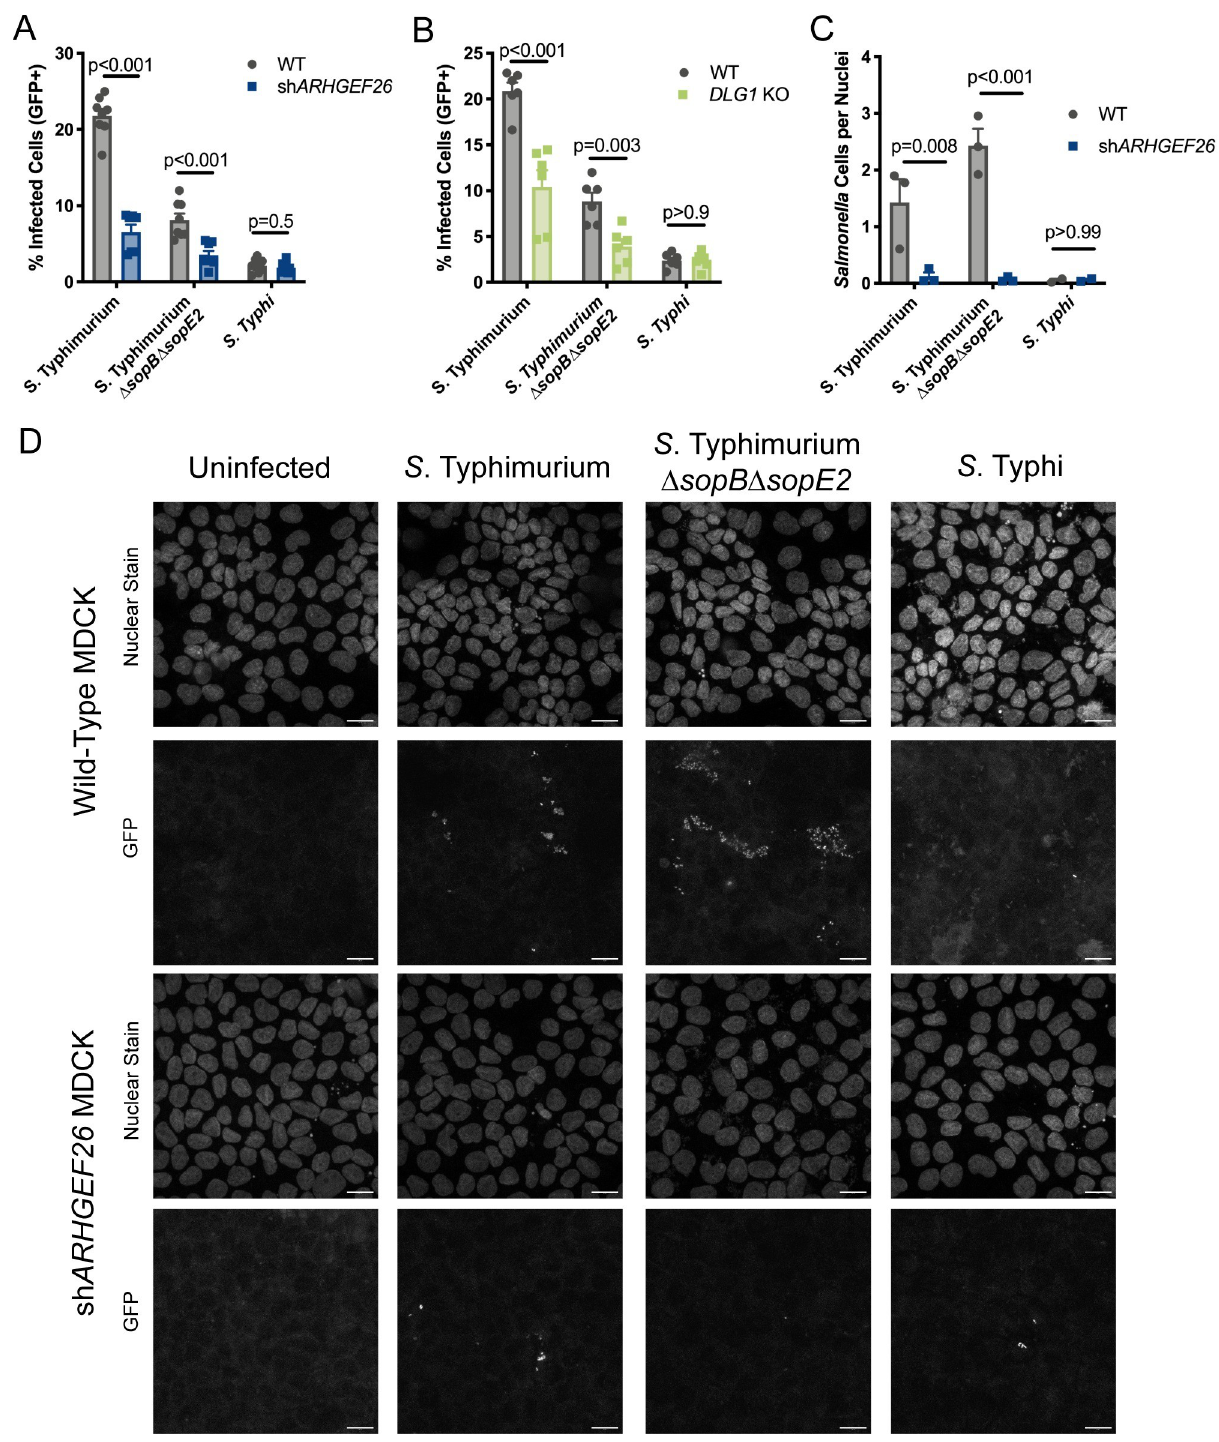
Fig 6. ARHGEF26 knockdown reduces polarized MDCK cell susceptibility to Salmonella Typhimurium invasion. (A) shARHGEF26 expressing polarized MDCK cells have reduced susceptibility to S . Typhimurium invasion independent of SopB and SopE2 compared to wild-type (WT) polarized MDCKs. (B) DLG1 knockout polarized MDCK cells have reduced susceptibility to S . Typhimurium invasion independent of SopB and SopE2. For panels A and B, cells were infected at MOI 30 ( S . Typhimurium) or MOI 100 ( S . Typhi) for 30 minutes before gentamicin treatment. The percent of host cells infected with Salmonella was measured three hours post infection by flow cytometry. All dots represent biological replicates from at least three experiments normalized to the grand mean. Bars represent the mean and error bars represent standard error of the mean. P-values for panels generated